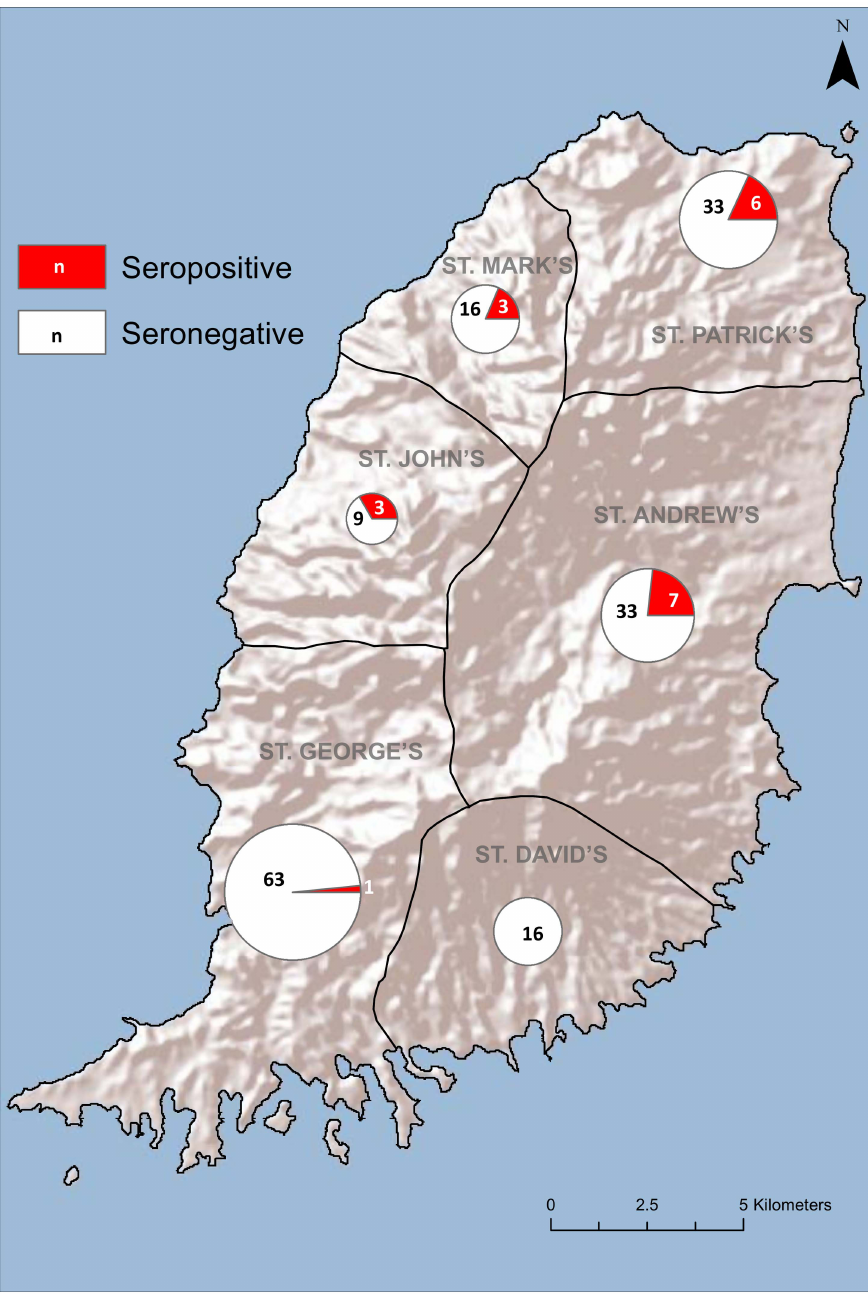
Figure 1. Number and distribution of mongooses trapped per parish in Grenada between Apr 2011 and Mar 2013. The proportions of seropositive mongooses are indicated, with the area of the circle proportional to the total number of animals trapped in each parish. Only one seropositive mongoose was caught during April 2011 and March 2012, in the parish of St Patrick.